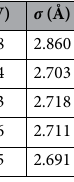
Table 2. Lennard–Jones (LJ) potential parameters considered in current